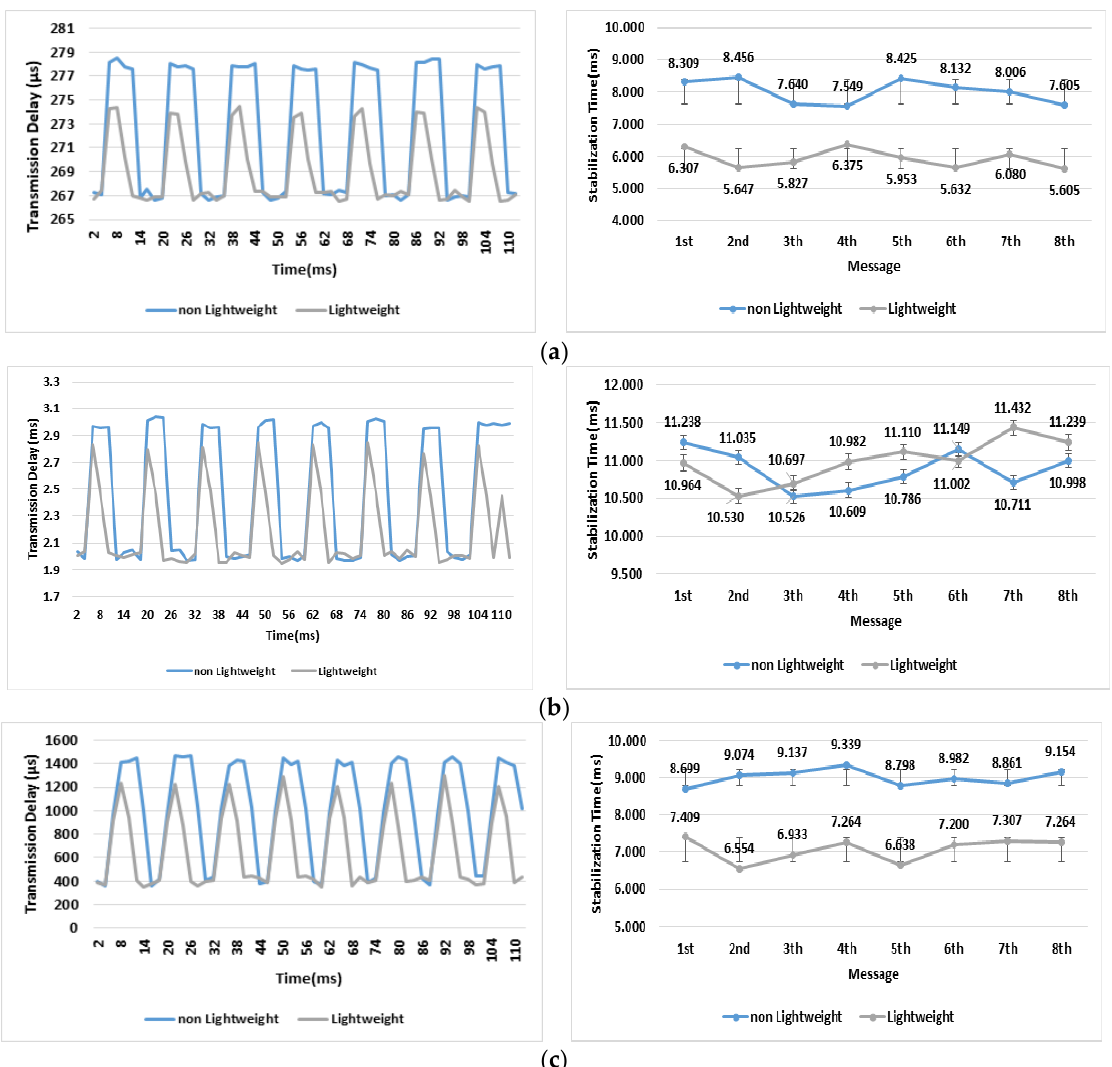
Figure 11. The transmission delay and the Stabilization Time when The CAN messages are translated. ( a ) From CAN to FlexRay, ( b ) From CAN to MOST, ( c ) From CAN to Ethernet.